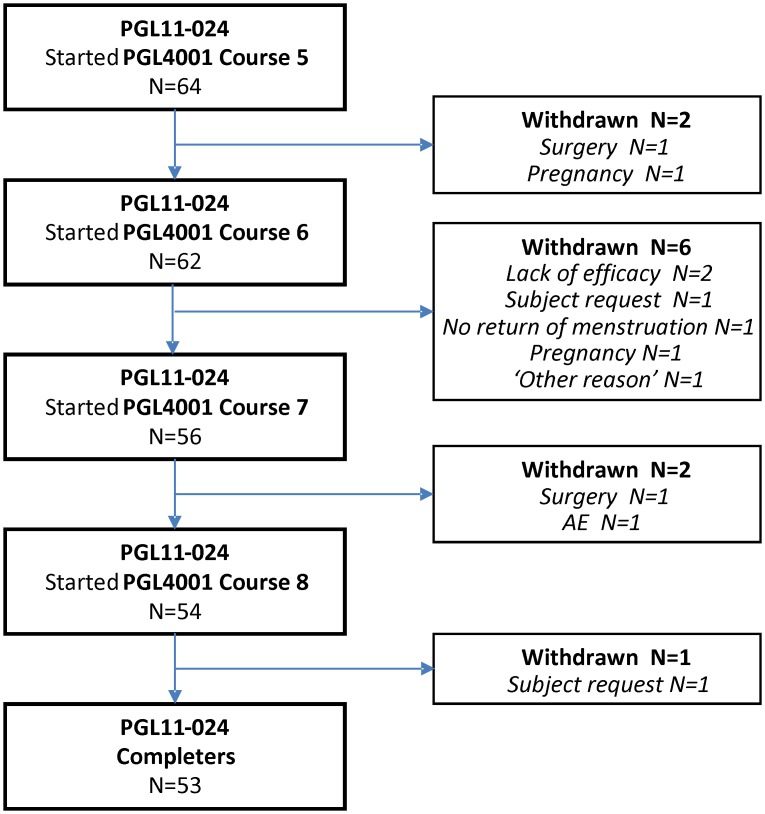
Flow chart of subject disposition during PEARL extension 2.Withdrawals are presented according to the timeframes in which they occurred, either during treatment or after treatment completion for each course.